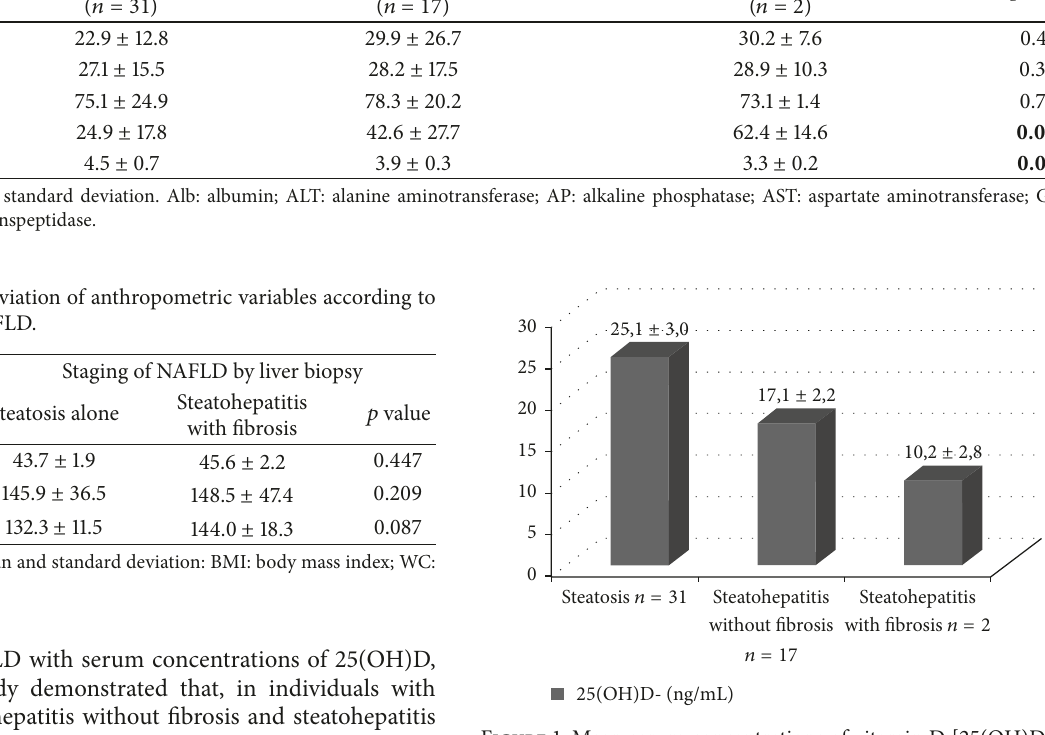
Table 4: Mean deviation serum concentrations of biochemical indicators of liver tests according to the staging of NAFLD. Variables